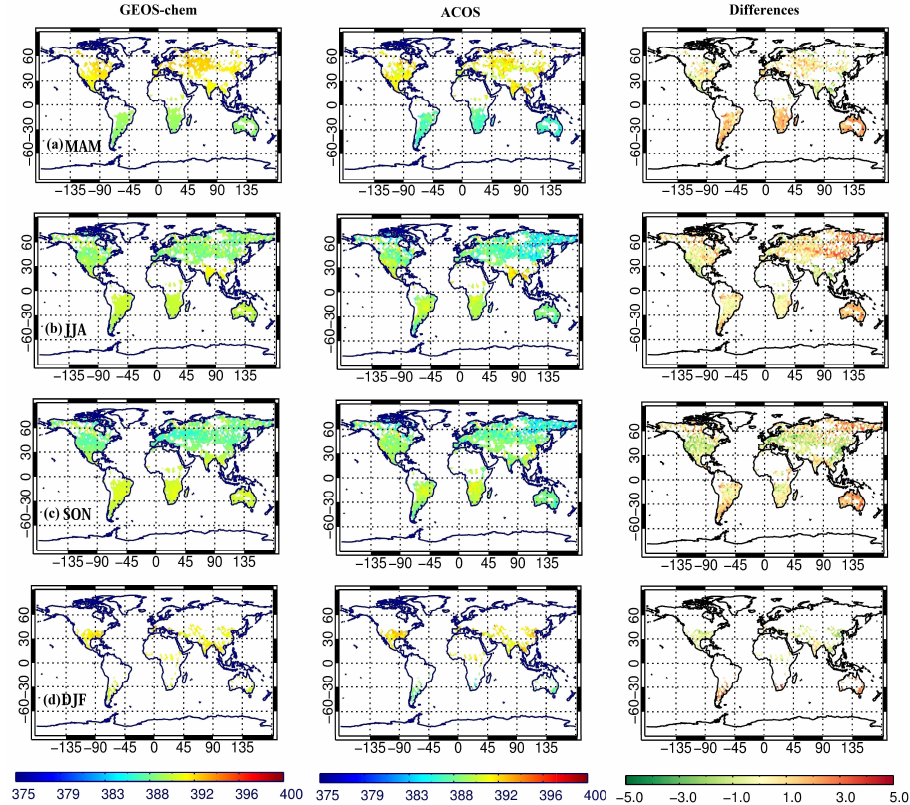
Figure 1. Comparison of XCO 2 simulated with GEOS-Chem and GOSAT/ACOSv7.3 XCO 2 products during March 2010–February 2011. Seasonal averaged XCO 2 concentrations are shown for GEOS-Chem, GOSAT/ACOSv7.3 and their differences (GEOS-Chem − ACOS): ( a ): MAM; ( b ): JJA; ( c ):